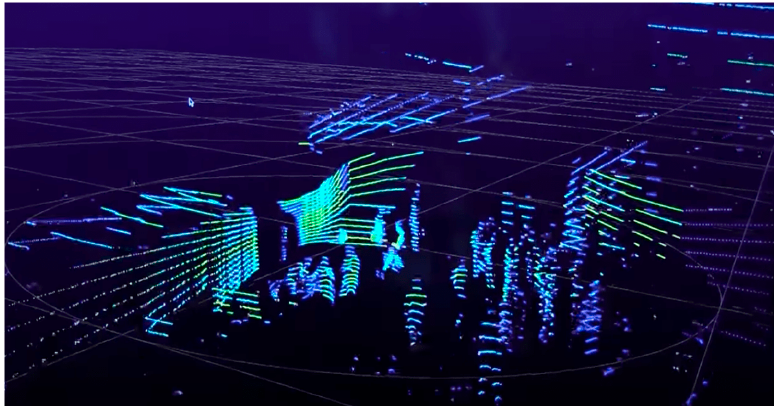
Figure 4. Raw LiDAR data of pedestrians, captured using Velodyne HDL sensor. (Images source: www.velodynelidar.com; accessed on 29 October 2021).